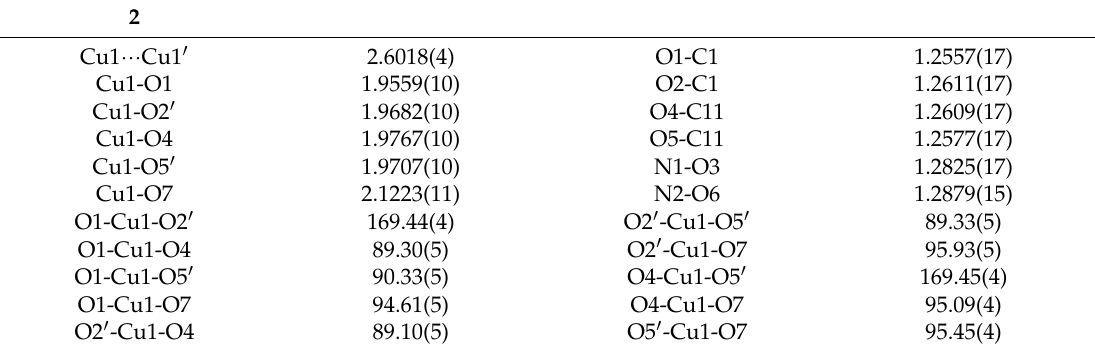
Table 6. Selected bond distances (Å) and angles ( o ), with esds in parentheses for 2 , 6 , 9 , and 10